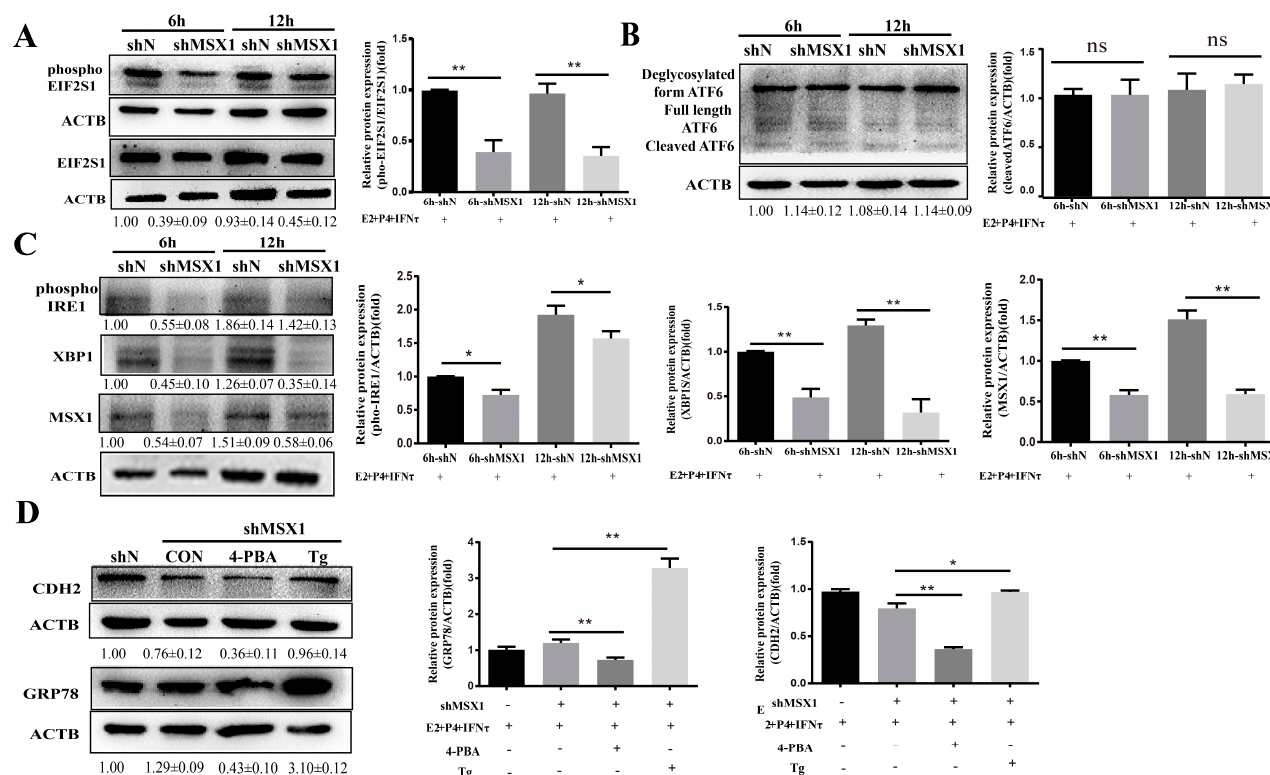
Figure 7. MSX1 regulated the expression of CDH2 via the ER stress-mediated UPR pathway. ( A ) Western blot and analysis results of EIF2S1and phosphoEIF2S1; ( B ) Western blot and analysis results of the cleaved and deglycosylated forms of ATF6; ( C ) Western blot and analysis results of phosphoIRE1 and XBP1; ( D ) shMSX1 EECs were treated with P 4 and E 2 , and they were pretreated with TG or 4-PBA followed by treatment with IFN τ for 6 h, showing the Western blot and quantitative analysis results of GRP78 and CDH2. ns: p > 0.05; * p < 0.05; ** p < 0.01.